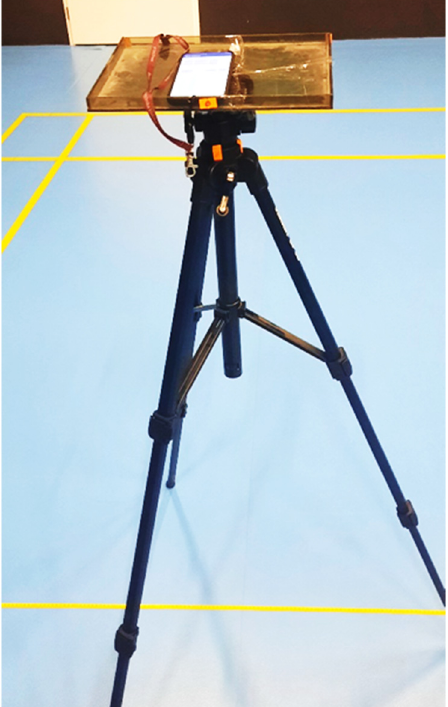
Figure 2. Stand used for manual data collection, consisting of a tripod and a mobile terminal on which an application for collecting measurement data is installed.